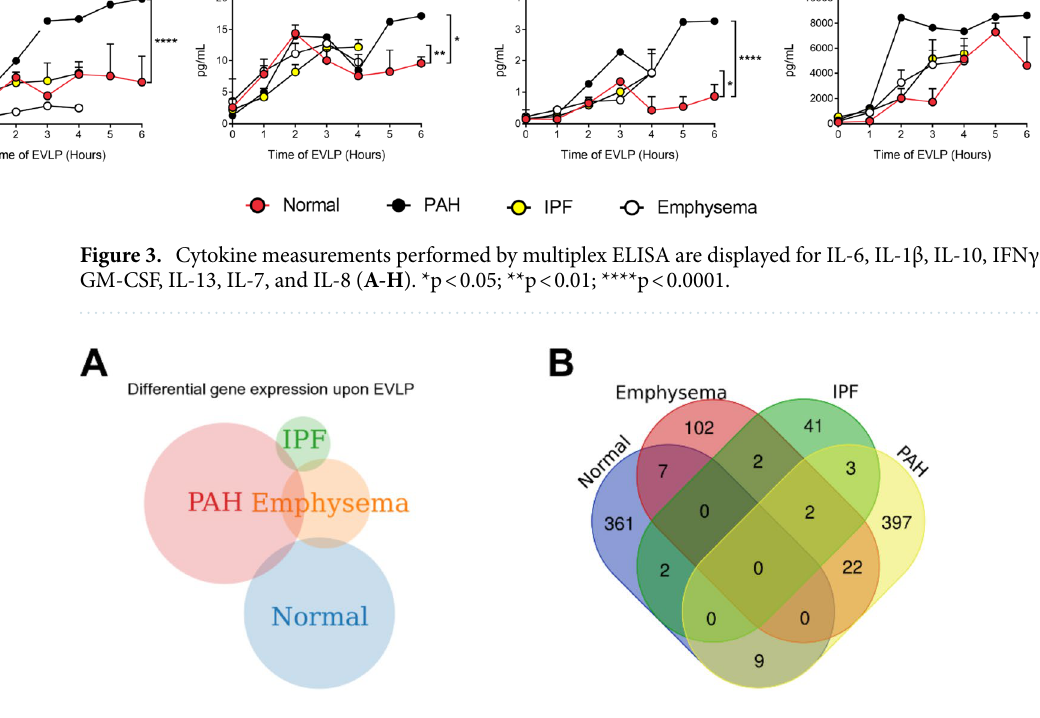
Figure 4. Differential Gene expression (DEG) in lung tissue biopsies taken from PAH, IPF, Emphysema, and Normal lungs at time 0 h vs. 6 h during EVLP expressed as Venn diagrams. ( A ) Shows a Venn diagram with proportional representation of the number of genes, and ( B ) shows the number of DEG in each of the